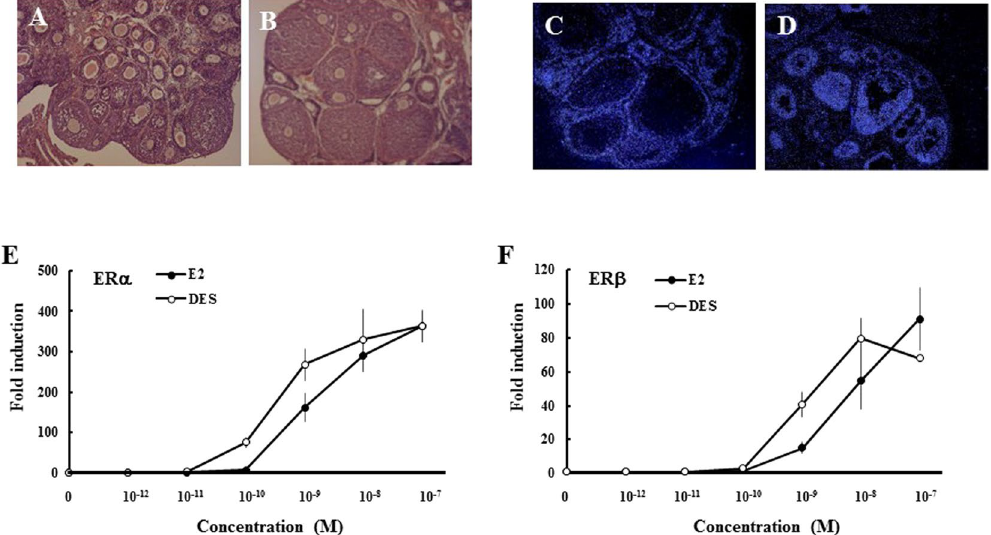
Figure 1. Effects of diethylstilbestrol (DES) and expression of estrogen receptors (ERs) in immature rat ovaries. Histology of immature ovaries before ( A ) or after quadruplicate DES treatment ( B ). Analyses of ER α ( C ) and ER β ( D ) mRNA localization in rat ovaries by in situ hybridization. Dose-dependent effects of estradiol (E2) and DES on the transactivation of rat ERs ( E , F ). COS-7 cells were transfected with a 5xGAL4-E1B/Luc expression vector and an ER-encoding vector. At 24 h post-transfection, cells were incubated with or